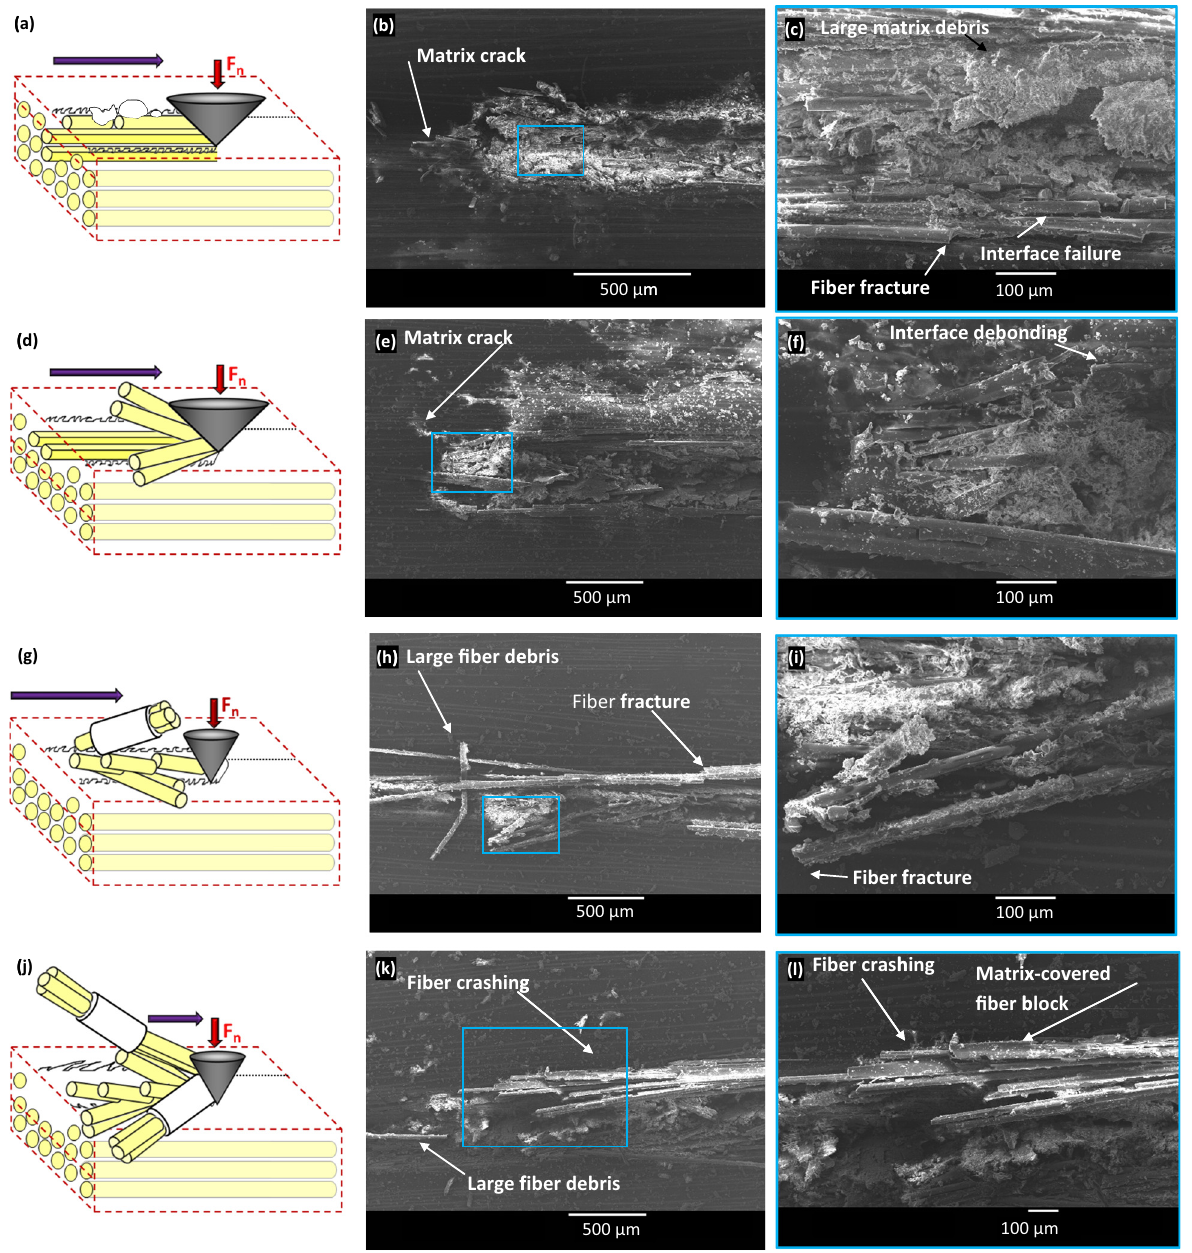
Figure 3: Wear scenarios and SEM micrographs emphasizing the SST // wear mechanisms. ( a – c ) θ = 45° − F n = 20 N, ( d – f ) θ = 45° − F n = 50 N, ( g – i ) θ = 60° − F = 20 N, and ( j – l ) θ = 60° − F = 50 n n